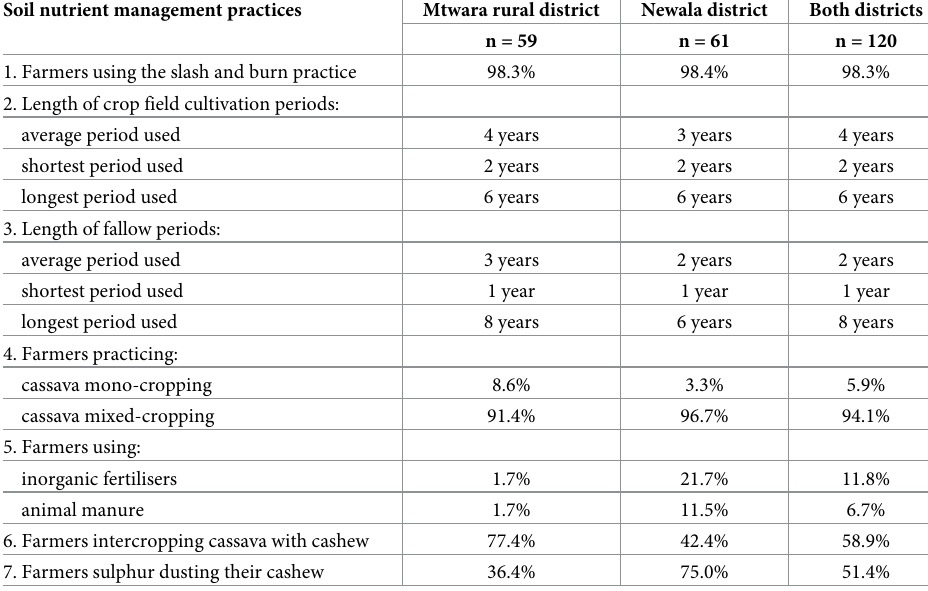
Table 1. Soil nutrient management practices used on cassava crop fields. Soil nutrient management